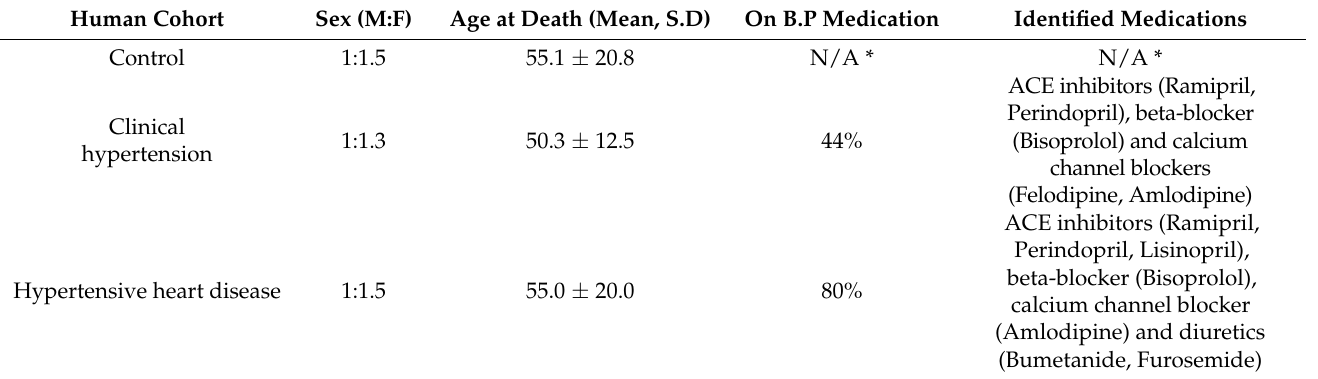
Table A1. Human patient demographics and clinical